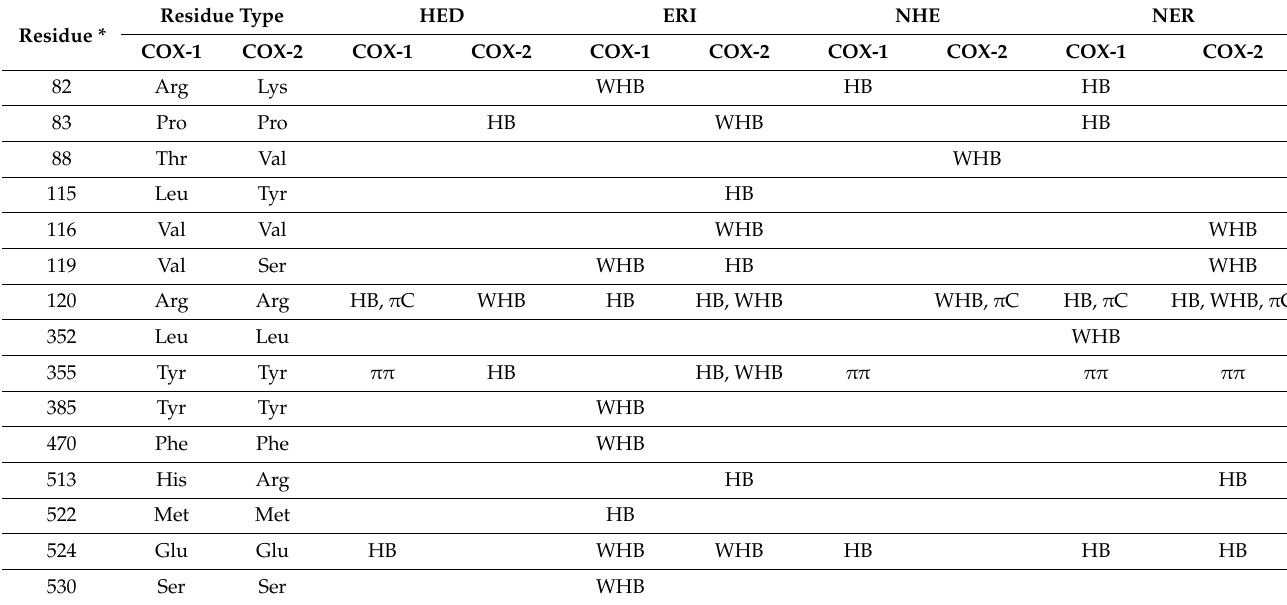
Table 3. Interaction patterns of docking-predicted bound conformations of HED, ERI, NHE, and NER with COX-1 and COX-2, detected during MD simulations HB = H-bond; WHB = water-mediated H-bond; π C = π –cation and ππ = π – π stacking. * To facilitate comparison between the two COX isoforms, residue numbering of COX-1 is applied to both